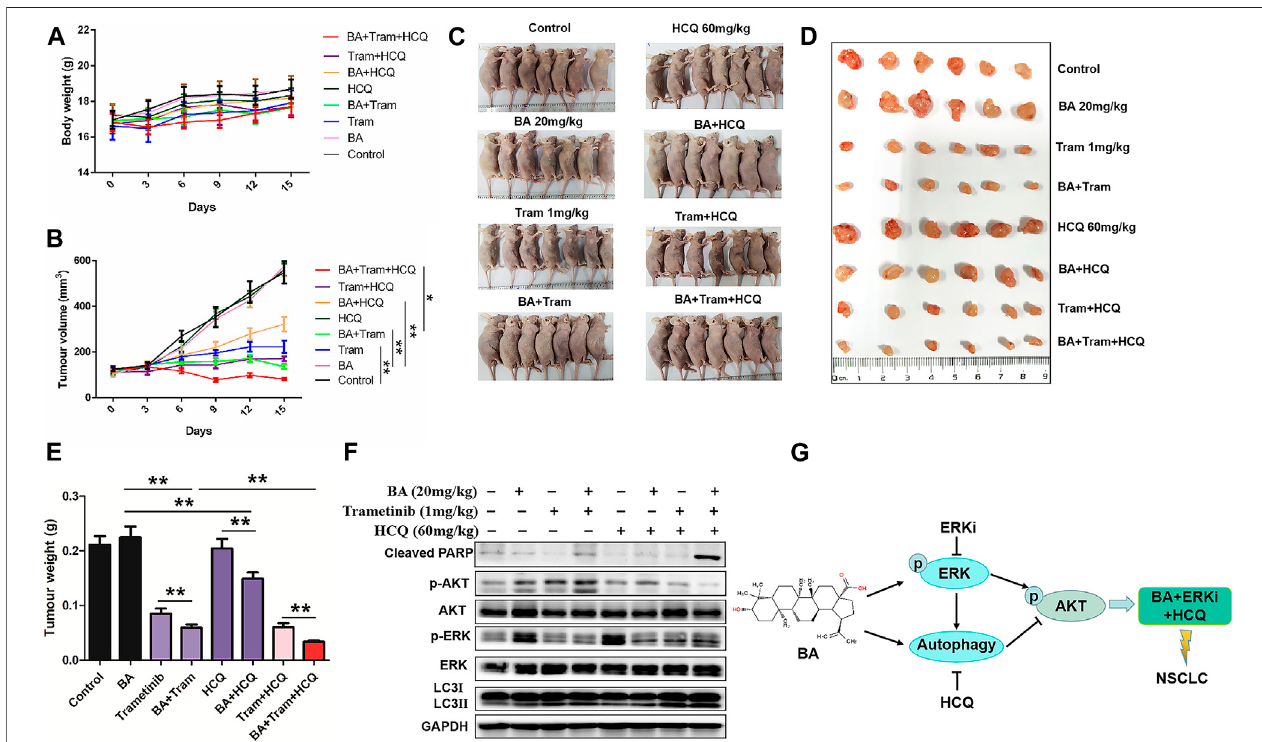
FIGURE 9 | Triple-drug therapy was the most effective for NSCLC in vivo . A549 xenograft mice were treated with the vehicle control, BA (20 mg/kg), trametinib (1 mg/kg),BA+trametinib,HCQ(60 mg/kg),BA+HCQ,trametinib+HCQ,andBA+trametinib+HCQ.Mousebodyweights (A) andtumorsizes (B) weremeasuredas indicated. (C) Aftertreatment for 15days, mice werehumanely euthanized,and images of mice from each group ( n (cid:2) 7) were shown. (D) Tumor photographs dissected out from the mice. (E) Average tumor weight of each group ( n (cid:2) 7). (F) The levels of AKT, p-AKT, LC3, cleaved PARP, ERK, and p-ERK1/2 in mice tumor were detected by Western blots. (G) Schematic illustration showing the basis for the combinatorial application. * p < 0.05, ** p < 0.01.